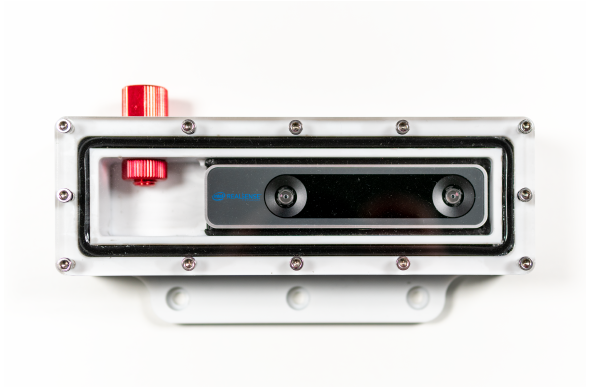
Figure 1. Custom underwater camera housing for the Intel T256.